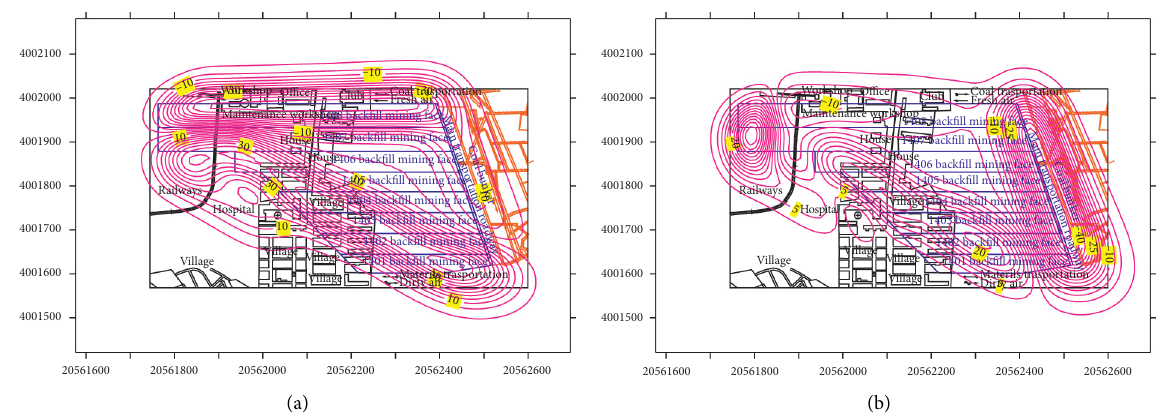
Figure 8: Contour map of horizontal surface movement in RMCPB. in the south-north line was 0.8 mm/m and that in the east- west one was 1.2 mm/m. The maximum inclination along the south-north and east-west lines was 1.6 and 1.8 mm/m, respectively. The maximum curvature along the south-north and east-west lines was 0.03 and 0.04 mm/m 2 , respectively.